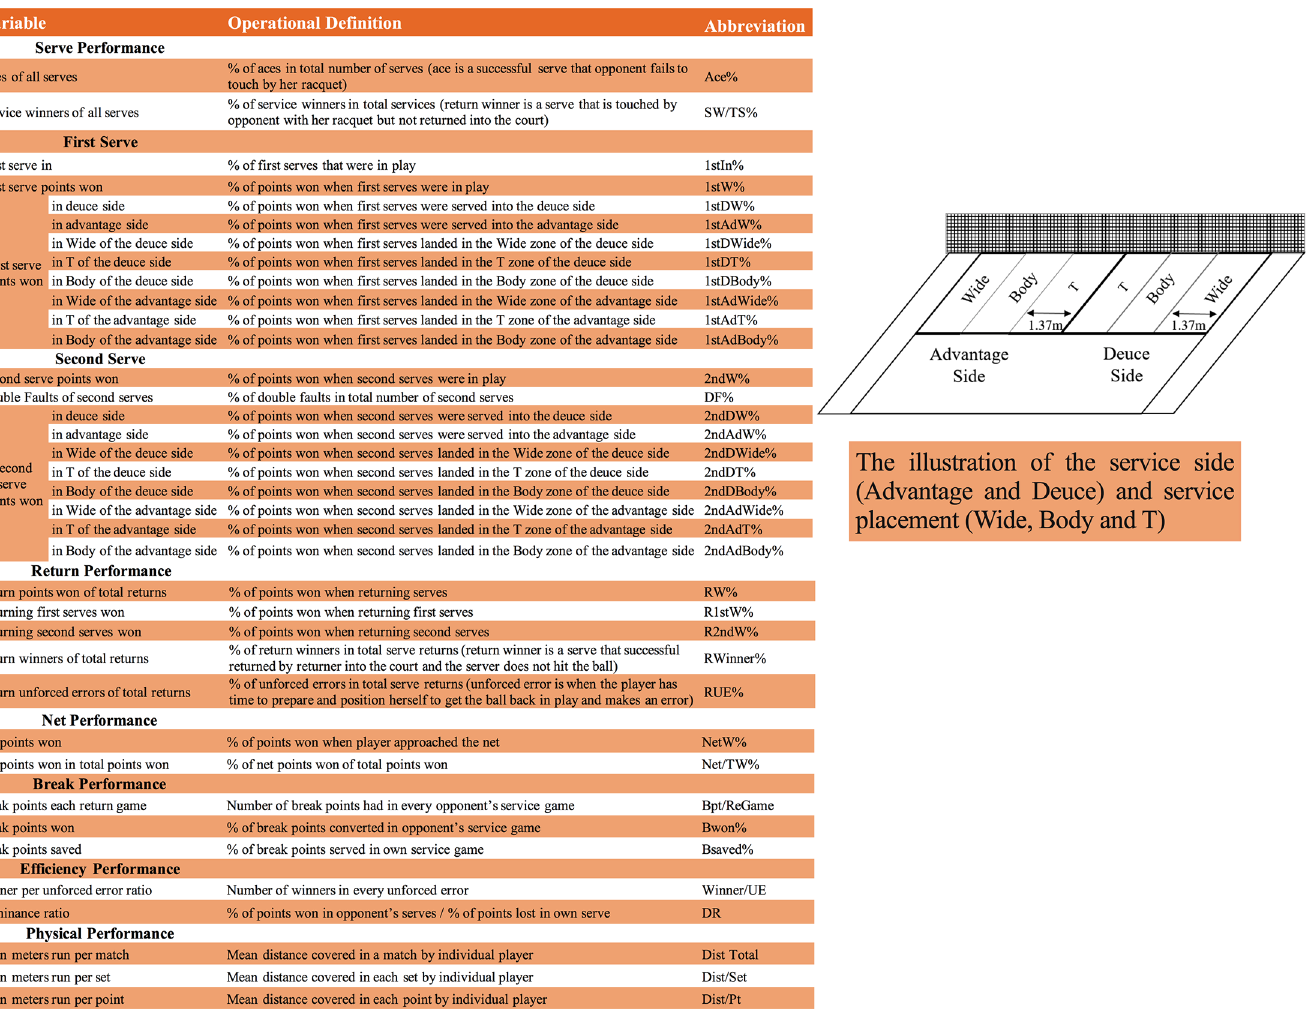
Fig 1. Match performance variables, operational definitions and